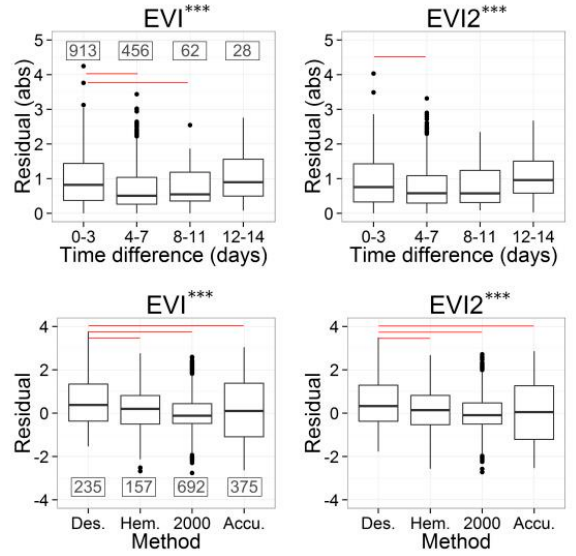
Figure 6. Boxplots of the absolute residuals summarized by temporal mismatch between LAI observations and satellite image acquisition (first row) and residuals summarized by measurement methods (second row) for the LAI-EVI and LAI-EVI2 relationships. The numbers in the EVI panel are the sample sizes for each category. In the boxplot, two ends of the boxes correspond to the first and third quartiles of the data, and the whiskers extend from the edges to the highest/lowest value that is within 1.5 * IQR of the hinge, where IQR is the inter-quartile range. Data beyond the end of the whiskers are plotted as points. The significance levels from ANOVA test (with Welch’s correction on non-homogeneity of variances) are shown on the title of each panel. The significance codes represent: *** <0.001; ** <0.01; * <0.05. Significantly different pairs ( α = 0.05) identified by the pairwise comparisons based on Dunnett's Modified Tukey-Kramer test are connected by lines. The red line indicates that the mean of the left group is significantly larger than that of the right